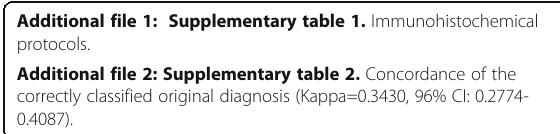
Additional file 1: Supplementary table 1. Immunohistochemical